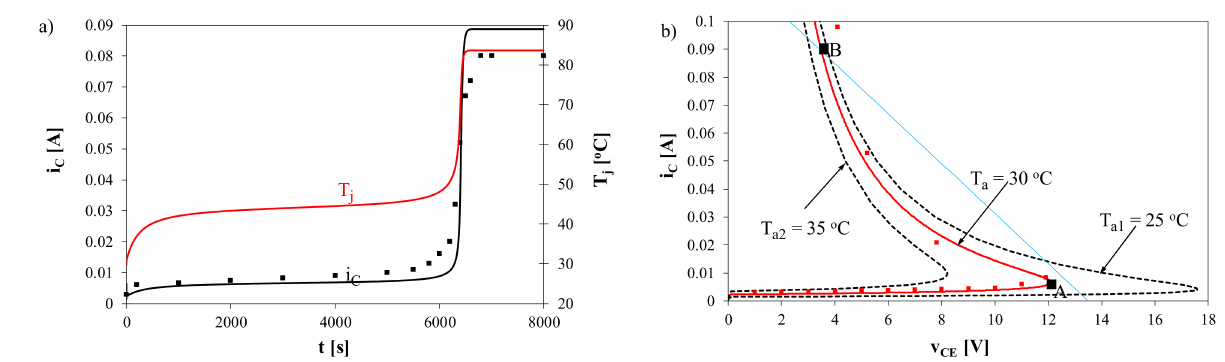
Figure 8. Dependence i C ( t ) and T j ( t ) ( a ), and the nonisothermal DC output characteristics ( b ) of the voltage-driven BJT at v BE = 0.63 V at three values of the ambient temperature for the transistor switch with the